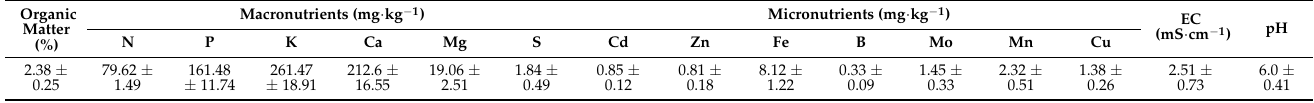
Table 1. The background values of nutrient elements, organic matter and electric conductivity